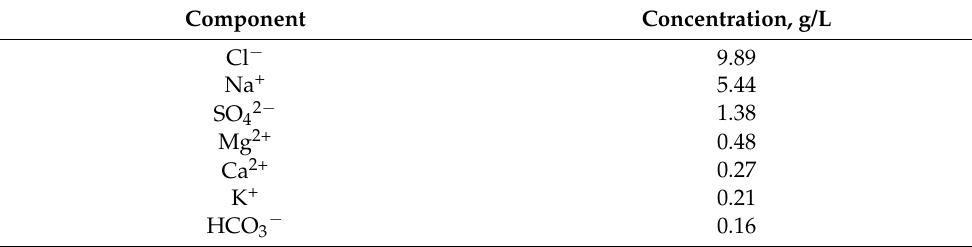
Table 2. Concentrations of major dissolved ions in used